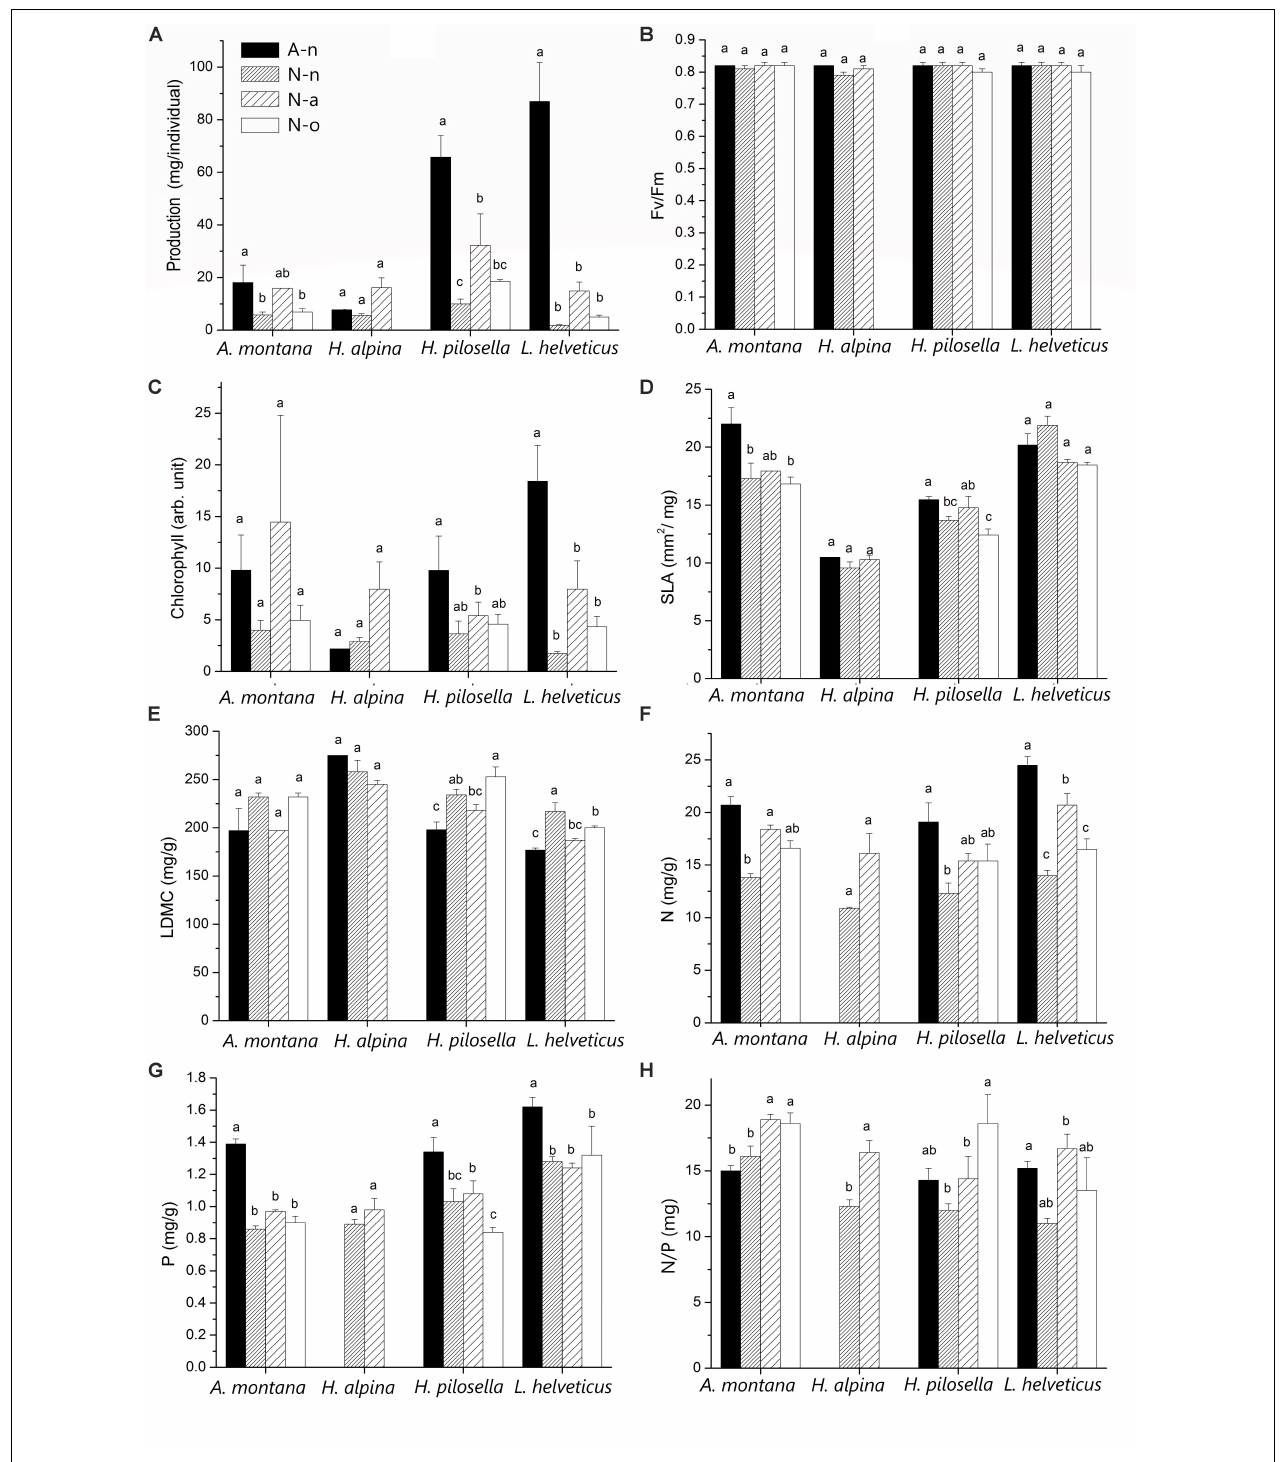
FIGURE 4 | Mean ( ± 1 SE; n varies among species and treatments in relation to availability of leaf material) values of (A) production, (B) chlorophyll fluorescence (F v /F m ), (C) chlorophyll content, (D) specific leaf area (SLA), (E) leaf dry matter content (LDMC), (F) foliar N concentration, (G) foliar P concentration and (H) foliar N/P ratio for each species at the alpine vegetation belt (site A) on its natural soil (A-n) and at the nival vegetation belt (site N) on its natural soil (N-n), on soil originating from site A (N-a) and under the OTC (N-o). Within each panel, different letters represent significant ( P < 0.05) differences.